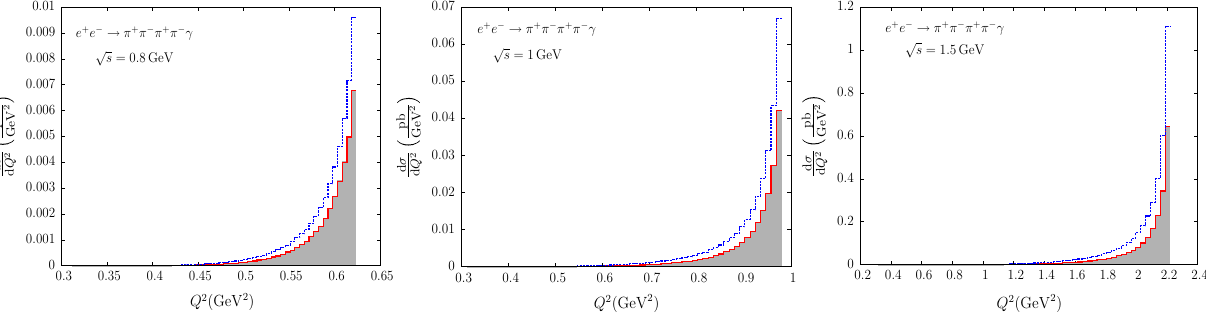
photons, the ISR (shaded histograms) and full LO (dashed lines) differential cross sections of processes (15), (16) and √ s = 1 GeV are plotted in Fig. 17 as func- (17) at tions of invariant mass of the π + π − -, π + π − μ + μ − and π + π − π + π − -systems, respectively. We see that this time the FSR effect is much